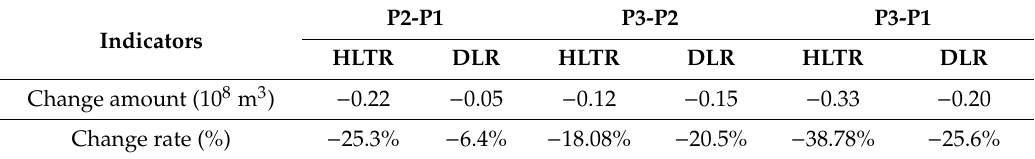
Table 3. Comparative changes in annual baseflow amount of two watersheds in di ff erent periods.